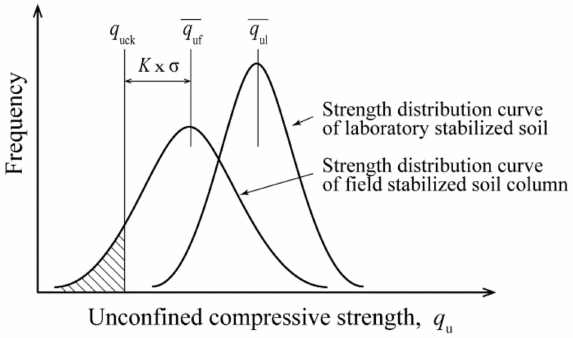
Figure 3. Field and laboratory strengths of stabilized